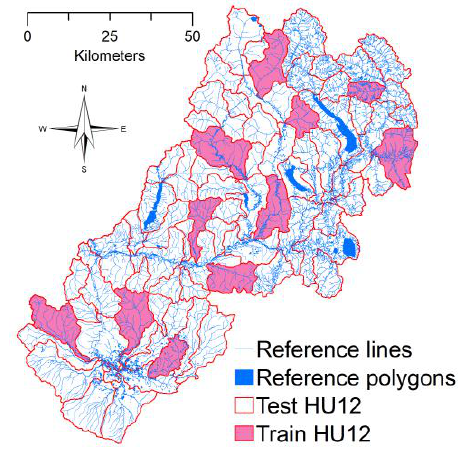
Figure 9. F1-scores for the base model study area summarized for training and test watersheds based on unfiltered and filtered (masked) reference